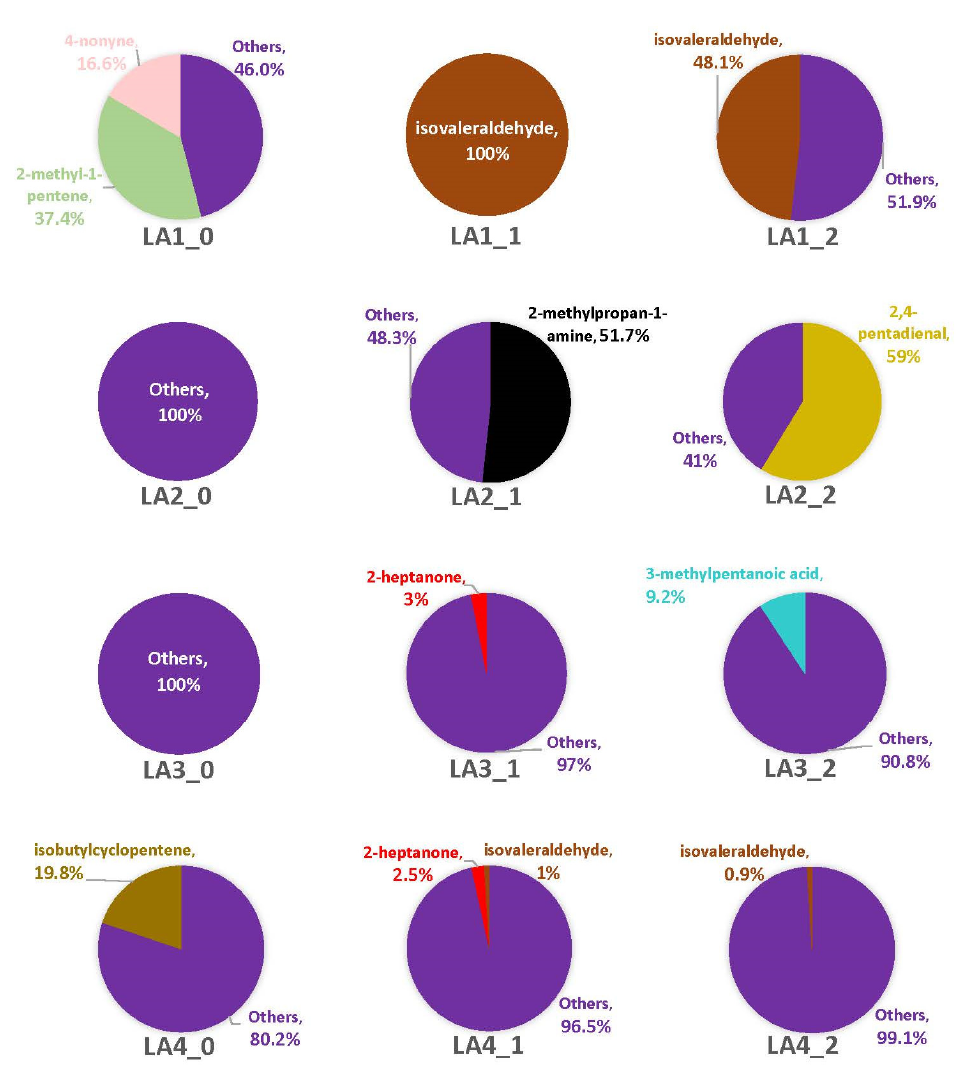
Figure 6. Average percentages (over three replicates) of VOCs contributing to total headspace profile of each Aspergillus strain while growing on cracked kernels of MI82, an A. flavus -resistant variety of corn, at each of three time points (48 h, one week, and two weeks).